Question: Compose a caption that would accompany this figure in a paper.
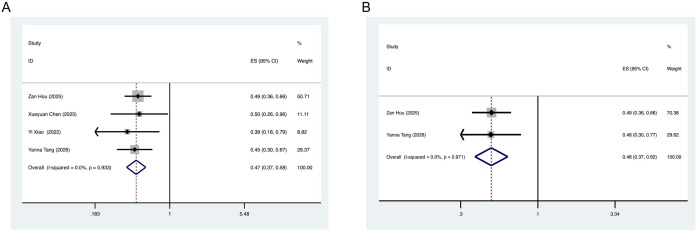
Answer: Forest plot of hazard ratios for PFS (A) and OS (B) in patients with PLELC receiving first-line chemo-immunotherapy versus chemotherapy alone. PLELC, pulmonary lymphoepithelioma like carcinoma; PFS, Progression-Free Survival;OS, overall survival.